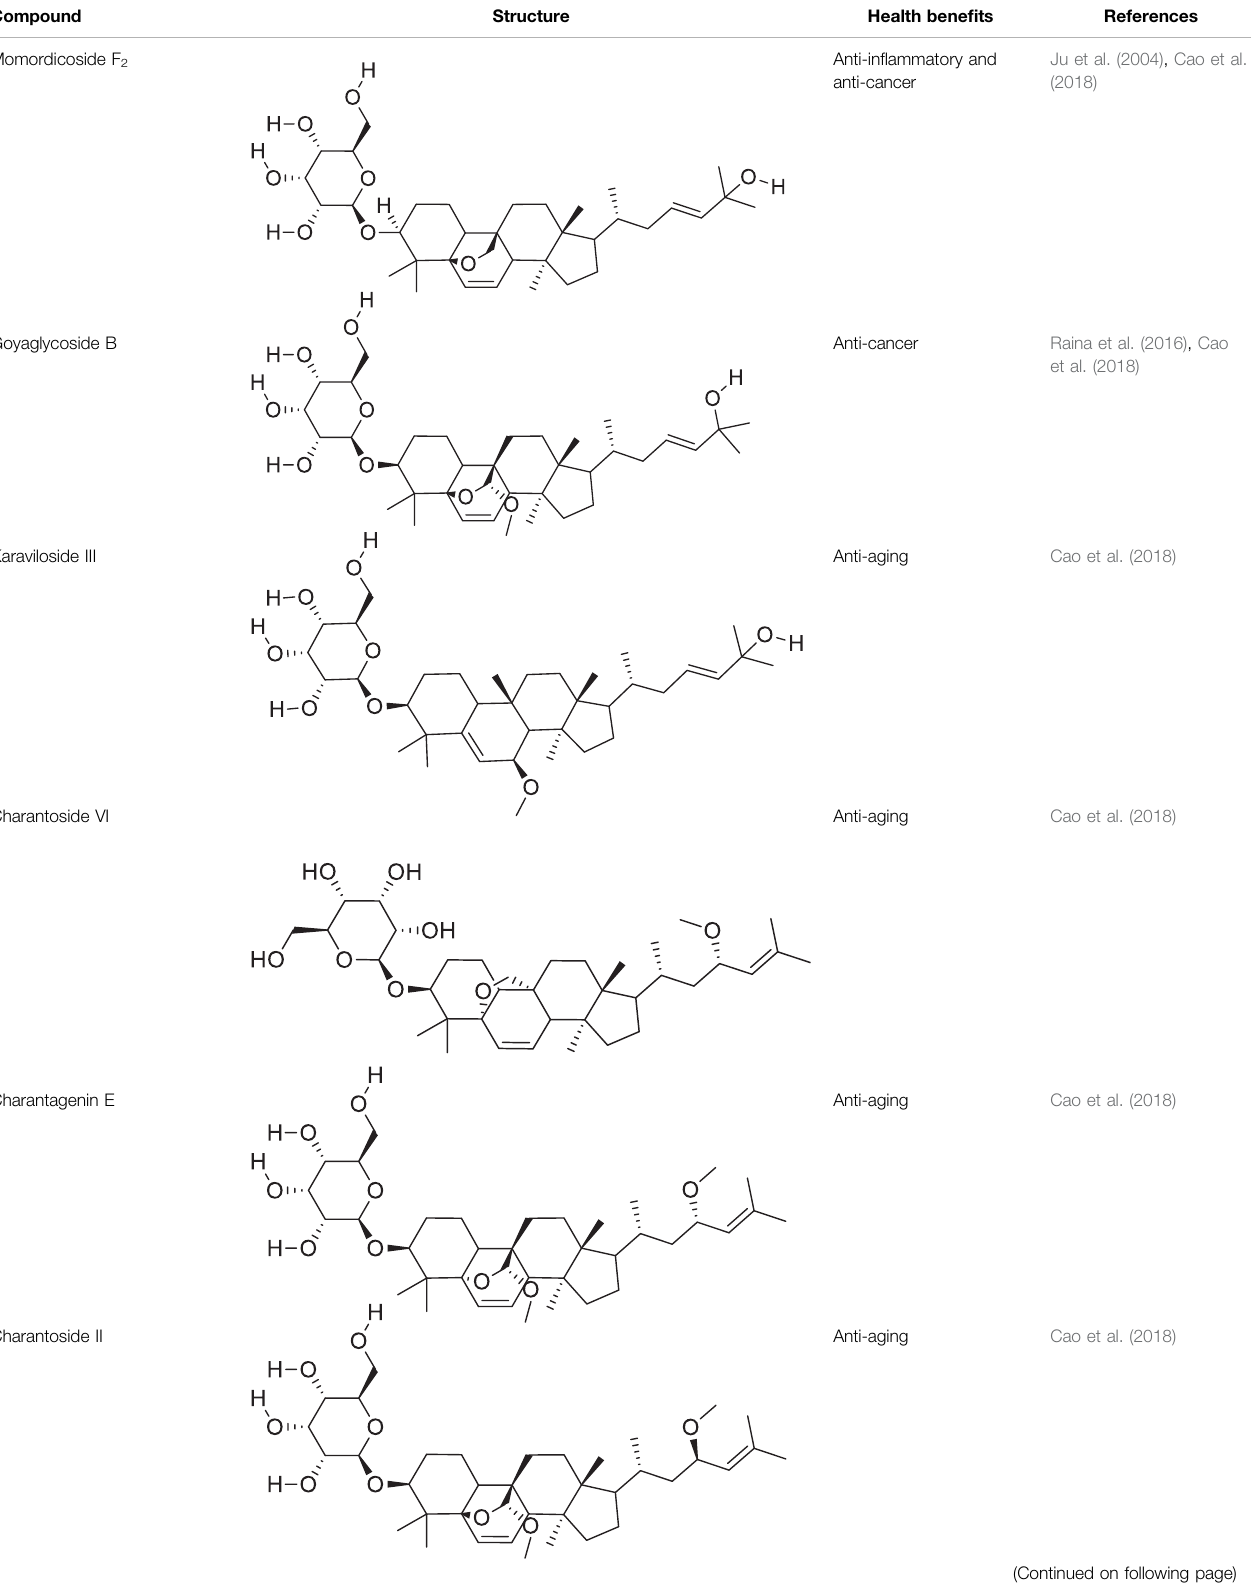
TABLE 1 | Compounds extracted from Momordica charantia L. and their health bene fi